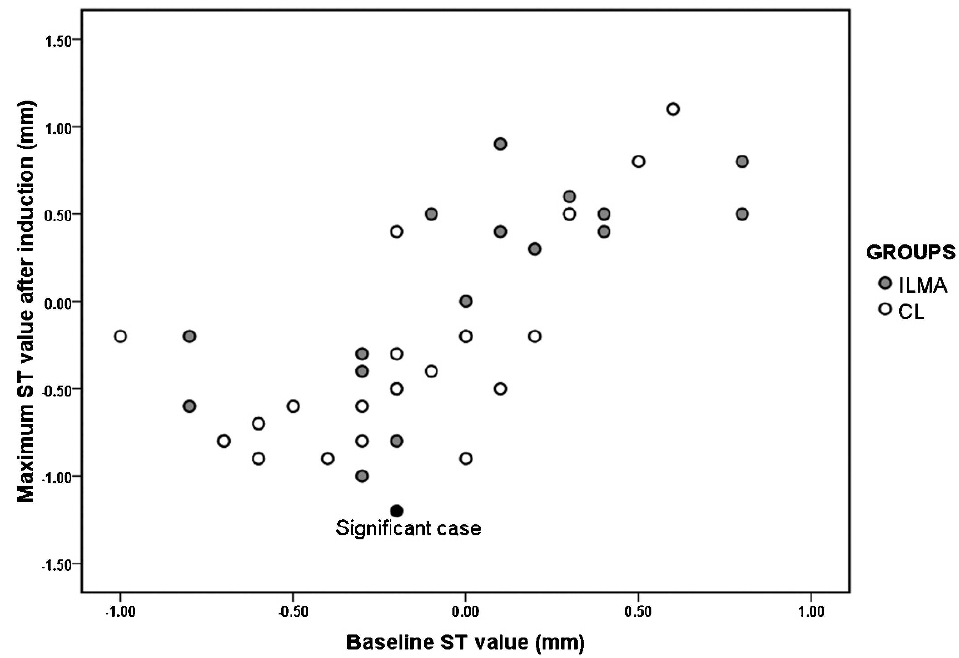
Figure 1 - The maximum and baseline ST values of